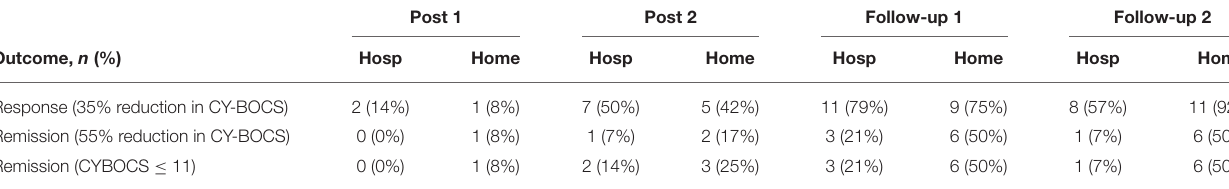
TABLE 3 | Levels of response and remission within groups at each time point.